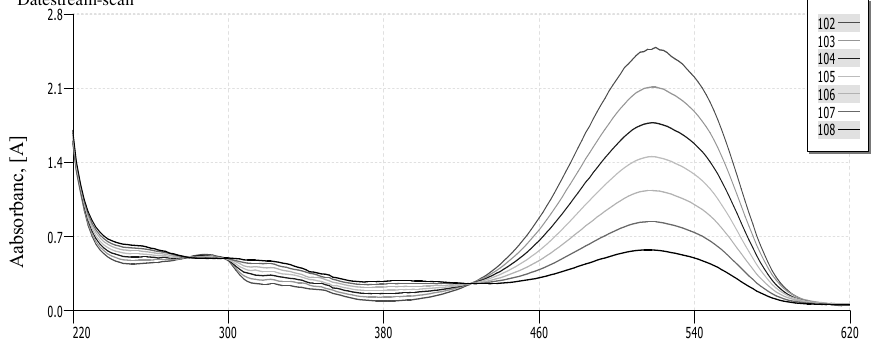
Figure 1. Absorption spectrum for the phenylhydrazine-methyl red-BrO